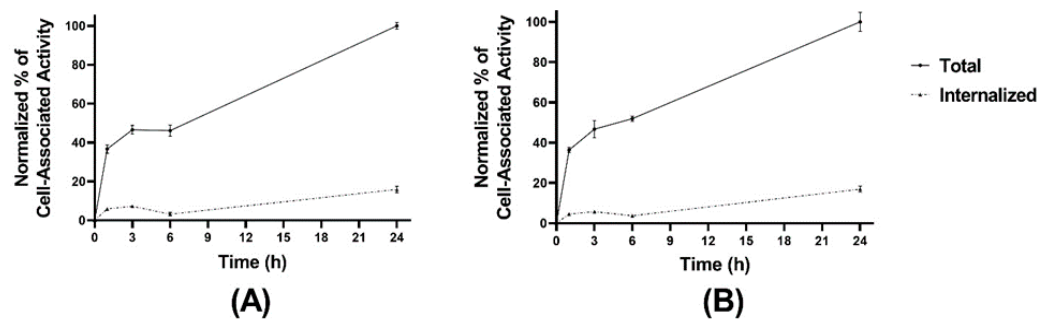
Figure 3. Cellular processing of [ 99m Tc]Tc-maSSS-PEG 2 -RM26 ( A ) and [ 99m Tc]Tc-maSES-PEG 2 -RM26 ( B ) at 1, 3, 6, and 24 h of incubation at 37 °C. The error bars represent the standard deviation.